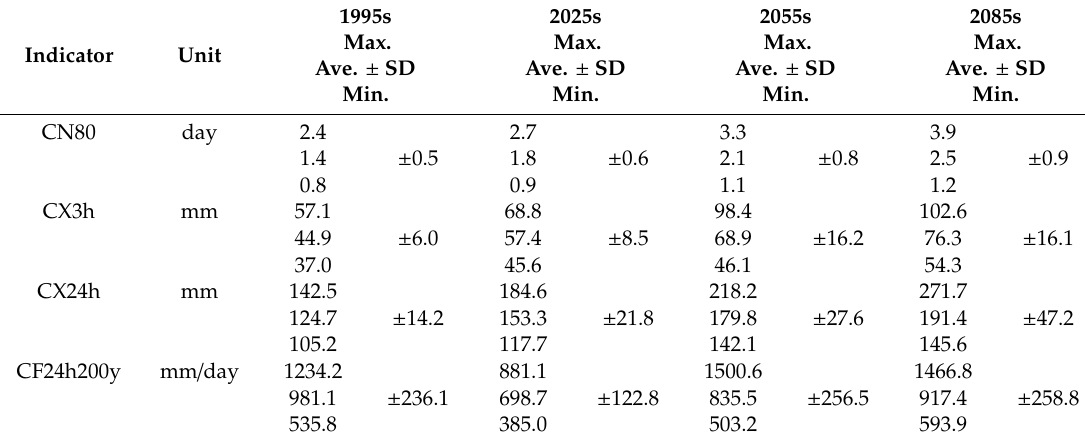
Table 3. Climate exposure indicators by periods under the representative concentration pathways (RCP) 4.5